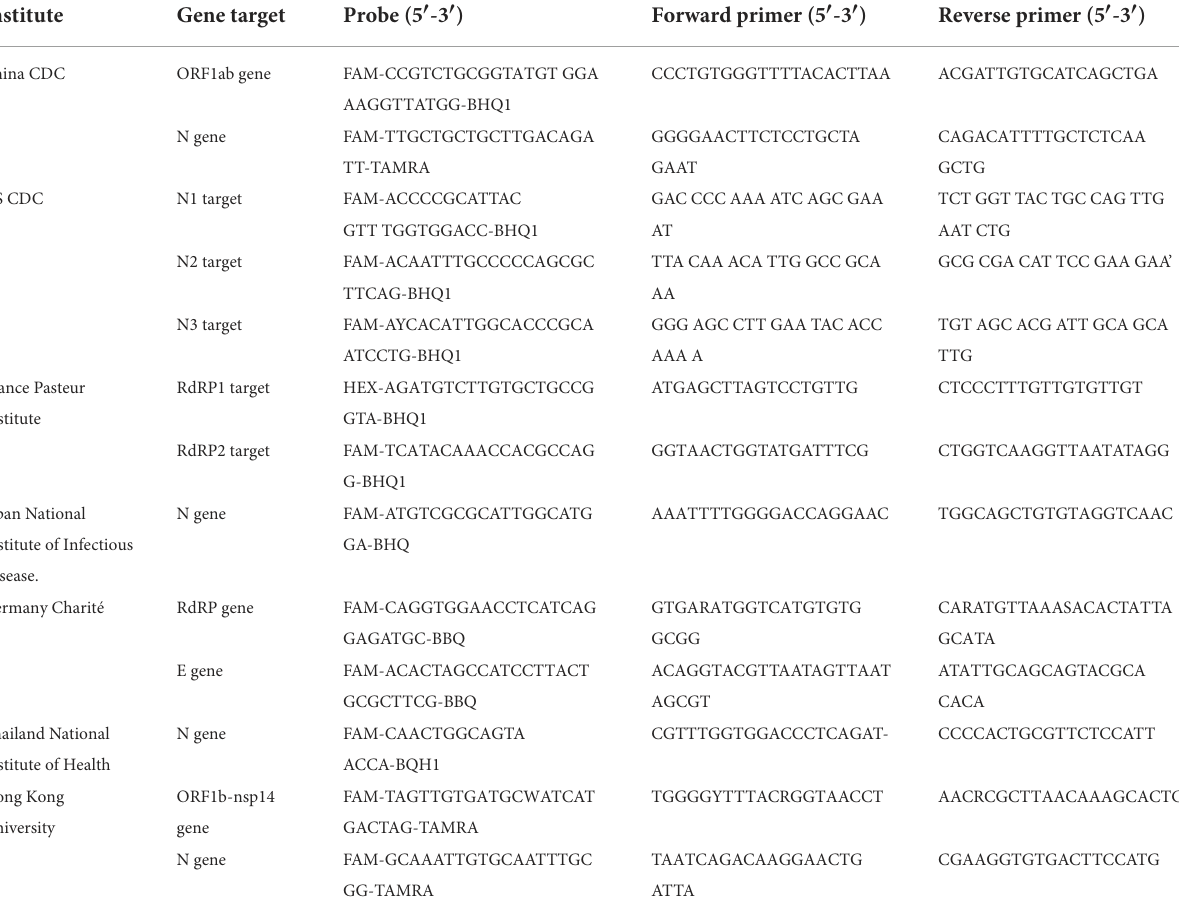
TABLE 2 List of different gene targets and primers used in lab-based and point-of-care nucleic acid amplification tests for SARS-CoV-2 around the world.